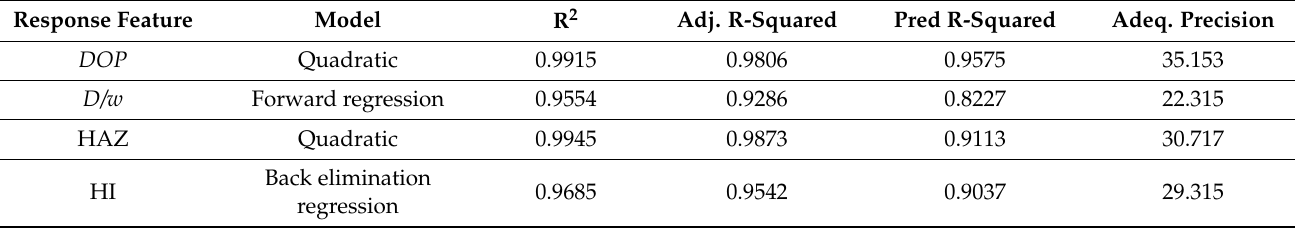
Table 6. ANOVA statistics for the generated models.